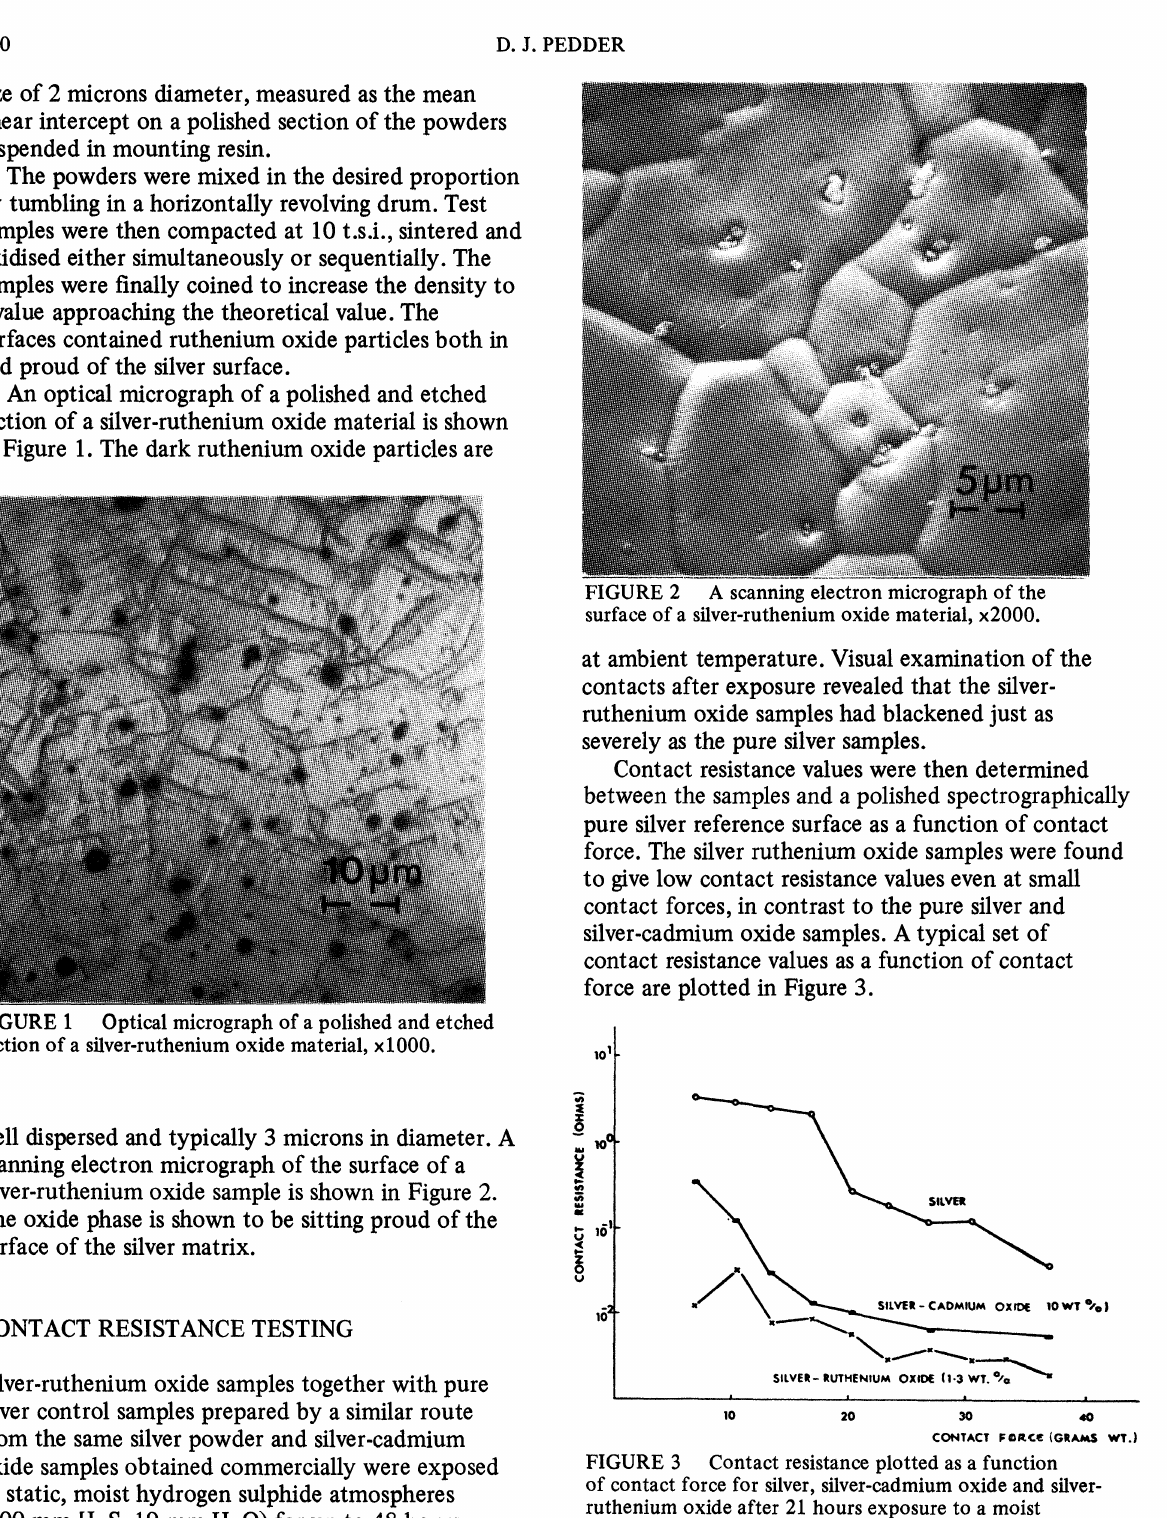
Contact resistance plotted as a function of contact force for silver, silver-cadmium oxide and silver- ruthenium oxide after 21 hours exposure to a moist hydrogen sulphide